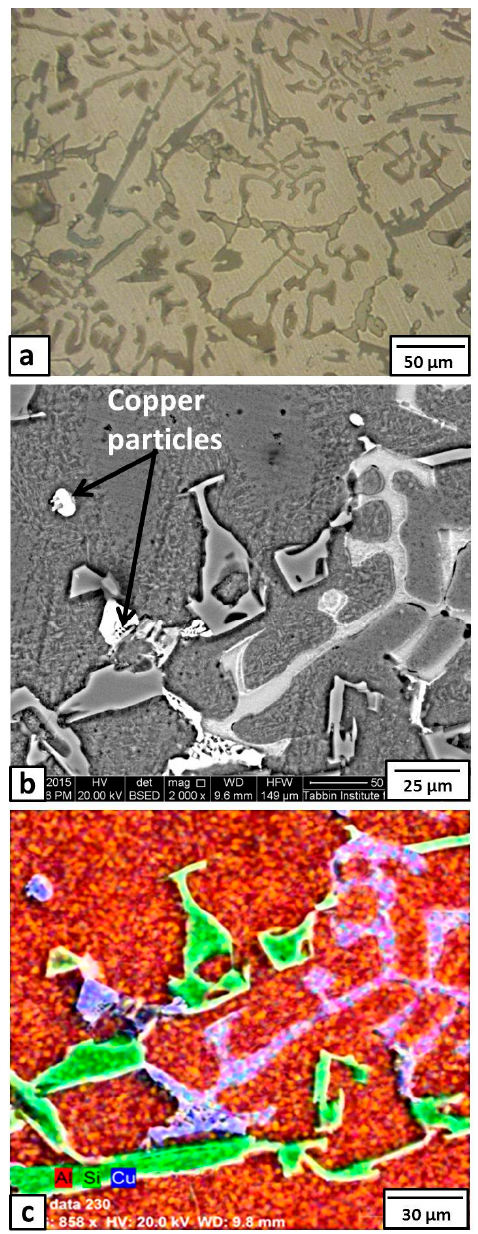
Figure 3. Microstructure of the formed composite after addition of 6% Cu; ( a ) optical micrographs; ( b ) enlarged SEM image; and ( c ) EDS element analysis of image ( b ).